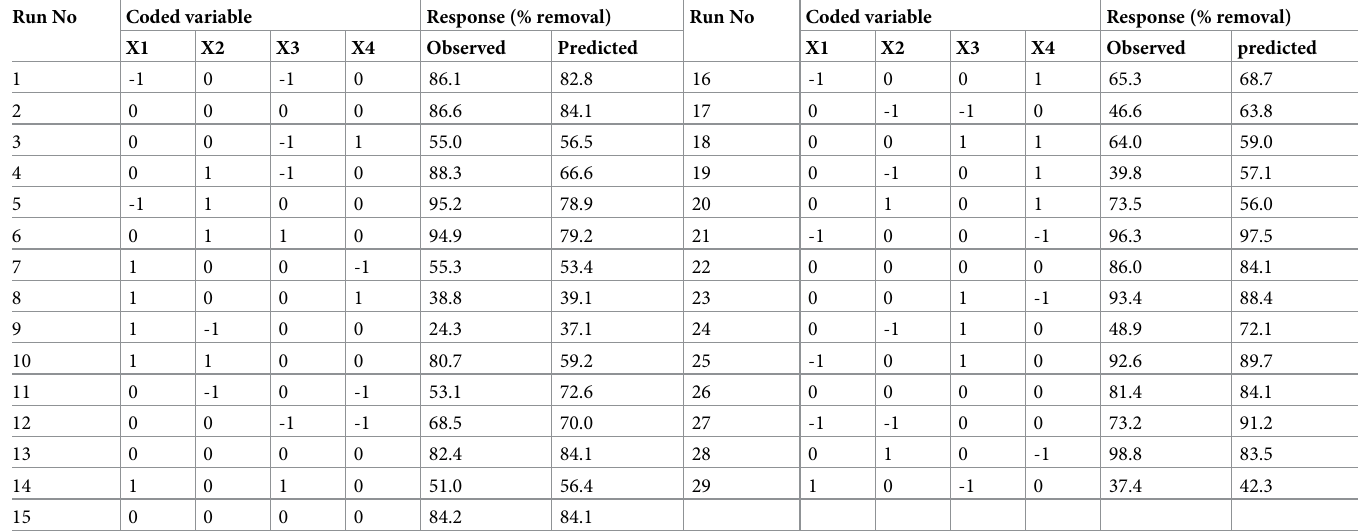
Table 3. BBD design of experiments for CIP removal.